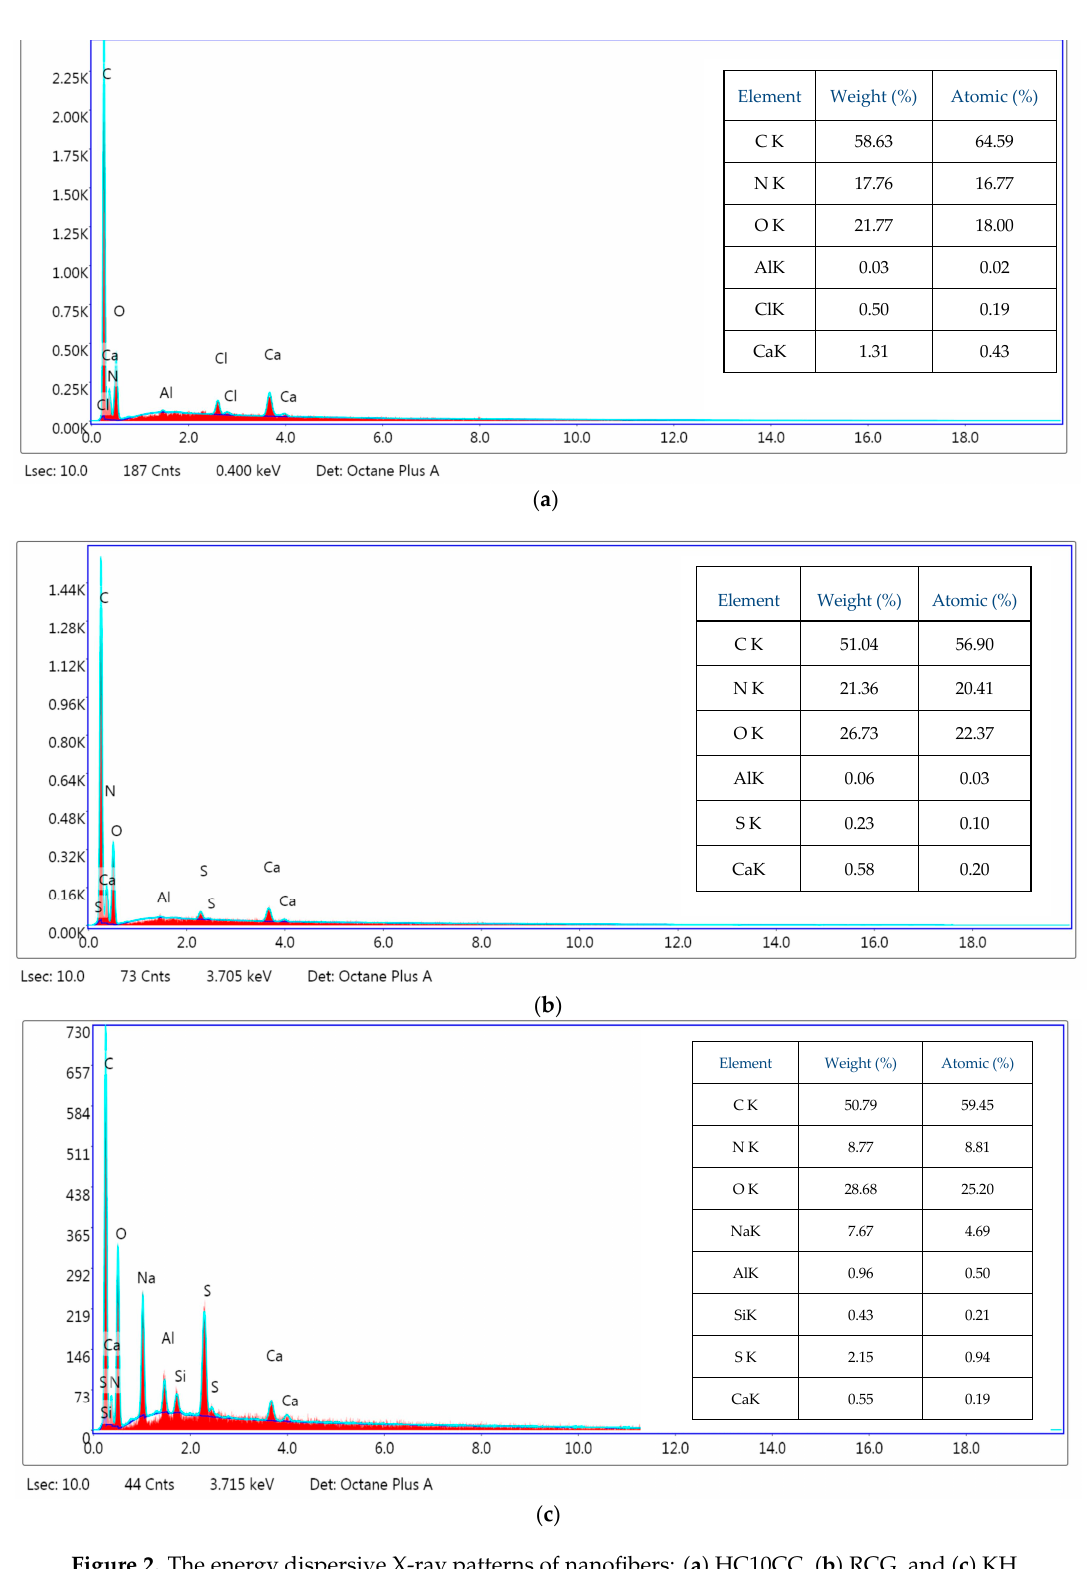
8 of 21 Figure 1. Scanning electron microscopy (SEM) images and fibers size for electrospun protein-based nanofibers: ( a , b ) HC10CC, ( c , d ) RCG, and ( e , f ) KH. Figure 1 shows that the morphology of electrospun protein-based nanofibers is influenced by their compositions and processing parameters of electrospinning. Using the chitosan solution mixed into a 65% acetic acid solution, HC10CC nanofibers with an average size of 171.9 nm were obtained (Figure 1a,b). By changing the spinning parameters, i.e., voltage of 20.53 kV, flow rate of 1.4 mL/h, and distance from needle to support collector of 8 cm, uniform RCG nanofibers without defects and an average diameter of 89.93 nm were observed (Figure 2c,d). Figure 2e,f shows the KH nanofibers